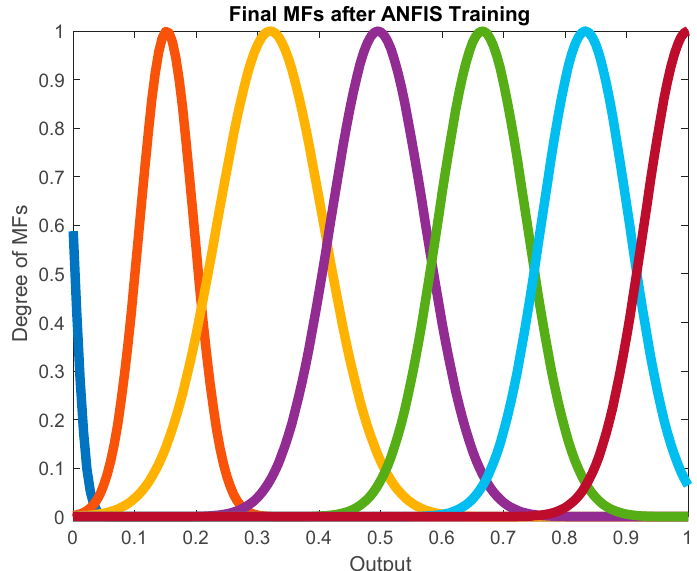
Figure 14. Final MFs after ANFIS training.